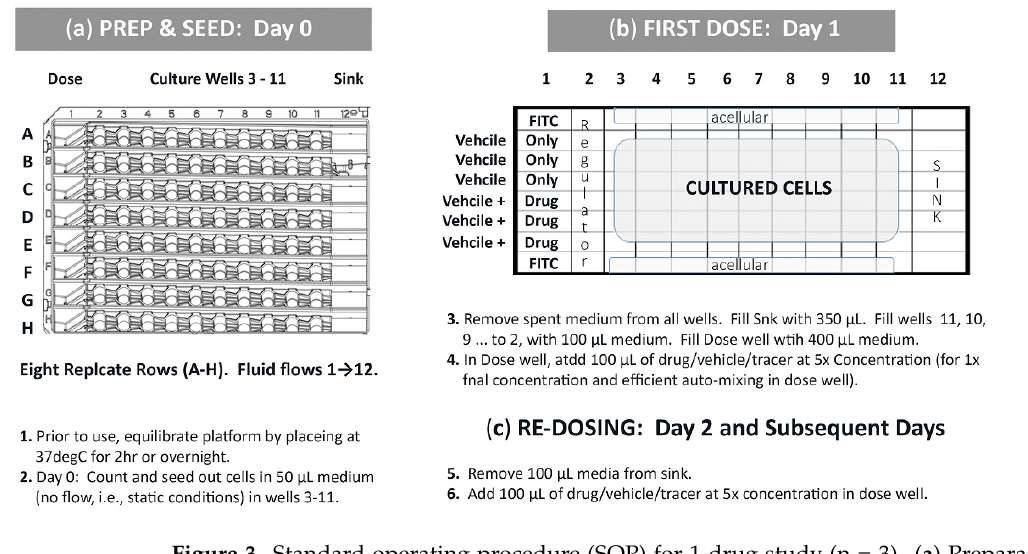
Figure 3. Standard operating procedure (SOP) for 1-drug study (n = 3). ( a ) Preparation and cell seeding. ( b ) First dose into well 1. ( c ) Re-dosing into well 1.